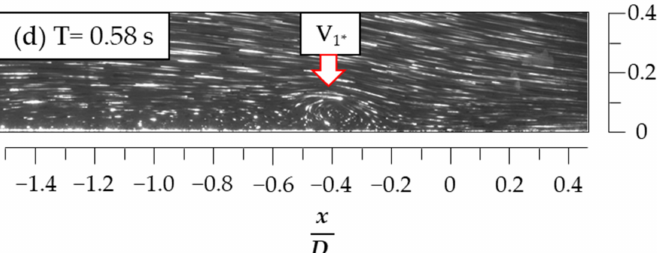
Figure 13. Time-series flow visualization of the HSV’s kinematic mode: “merging” in the z = 0.8 cm plane when H / D = 1.5. ( a ) The cores of two primary vortices V 1 and V 2 were initially located at ( x / D , y / D ) = ( − 0.31, 0.10) and ( − 0.73, 0.06), respectively; from ( b ) to ( c ), V 2 and V 1 were approach- ing and merging with each other; ( d ) a new primary vortex V 1* formed with its core located at ( x / D , y / D ) = ( − 0.38, 0.06).